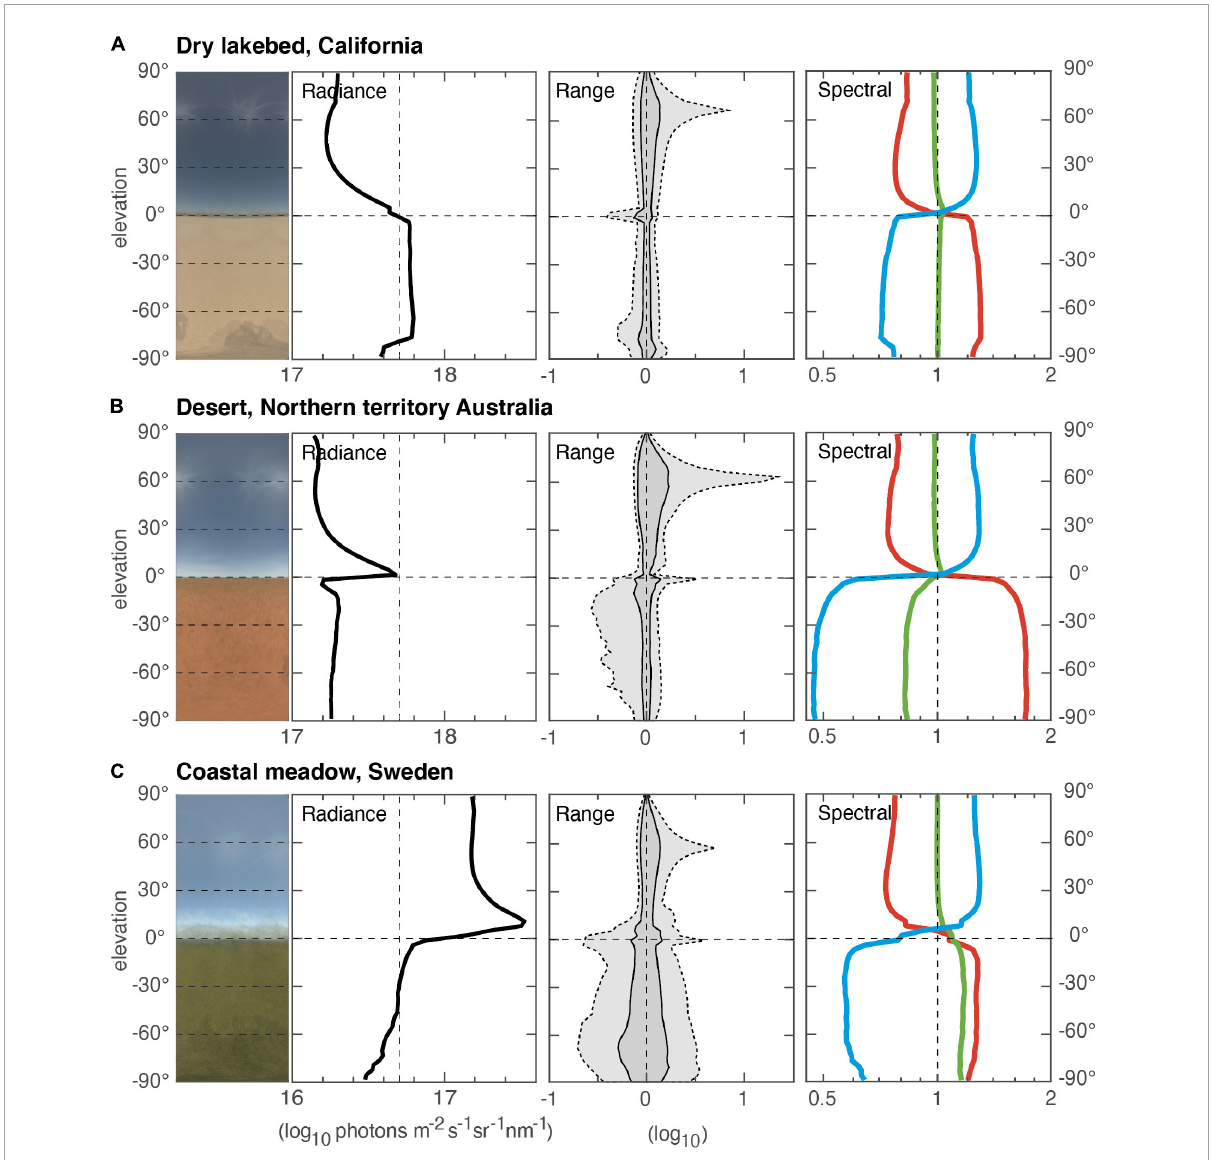
FIGURE3 Open environments of different types. (A) Dry lakebed near Lancaster, California, United States (measurement based on 14 scenes, 13 April 2015, start 11:25, duration 7 min). (B) Desert with red dirt near Tilmouth Well, Northern Territory, Australia (measurement based on 23 scenes, 6 April 2019, start 12:37, duration 6 min). (C) Coastal meadow at Hovs Hallar, southern Sweden (measurement based on 22 scenes, 30 May 2020, start 16:17, duration 5 min). All environments, (A–C) , were measured on clear, sunny days when the sun was at least 45 ◦ above the